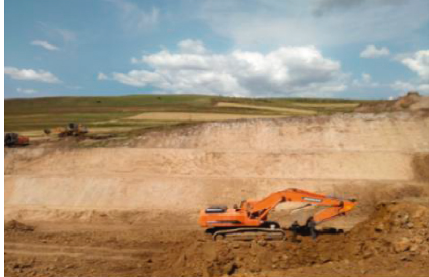
Figure 8: The effect after spraying.